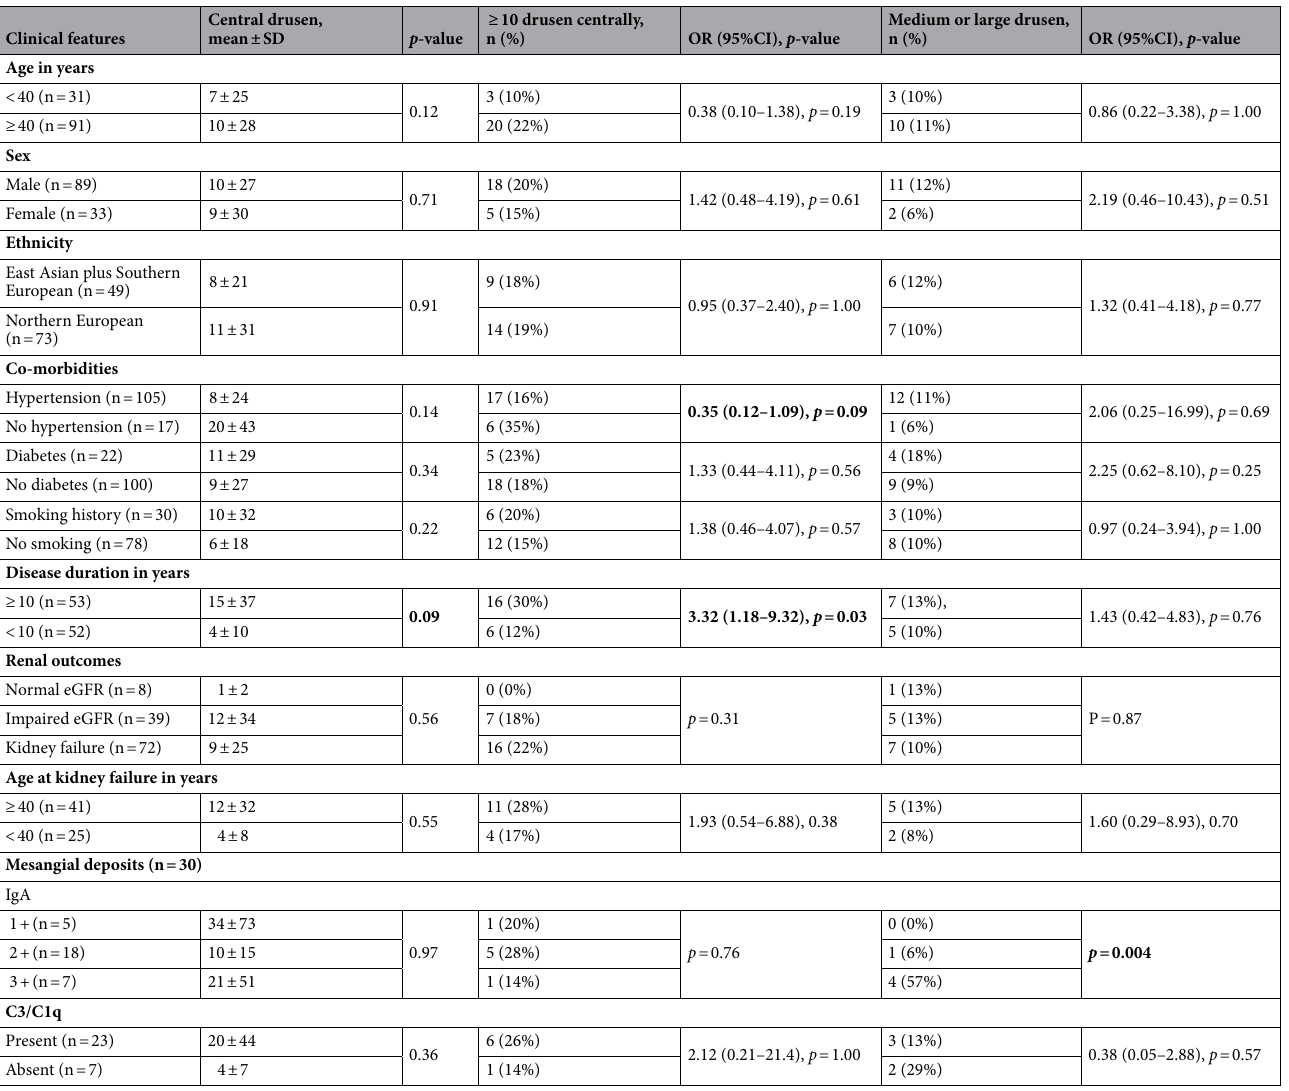
Table 3. Demographic and clinical associations of drusen in individuals with IgA glomerulonephritis. eGFR Estimated glomerular filtration rate mL/min/1.73m 2 , SD Standard deviation, OR Odds ratio, CI Confidence interval. Significant values are in